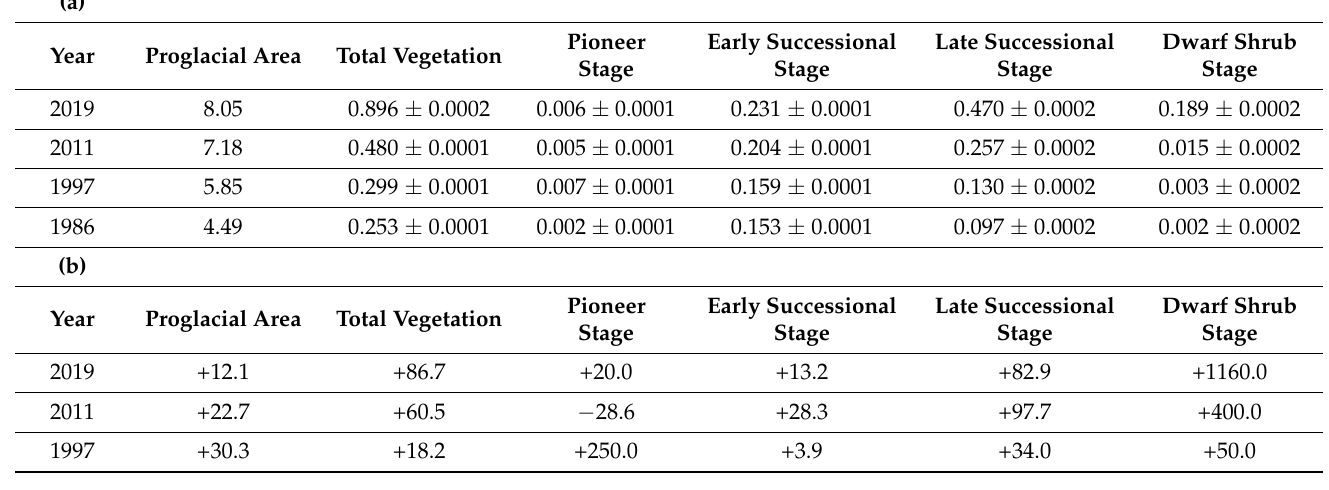
Table 5. Proglacial area and area with vegetation cover, analyzed for the different plant communities and four observation periods, expressed as (a) glacier area (km 2 ), total area covered with vegetation (km 2 ) and the standard error (b) percentage change of the area in comparison to the preceding period.